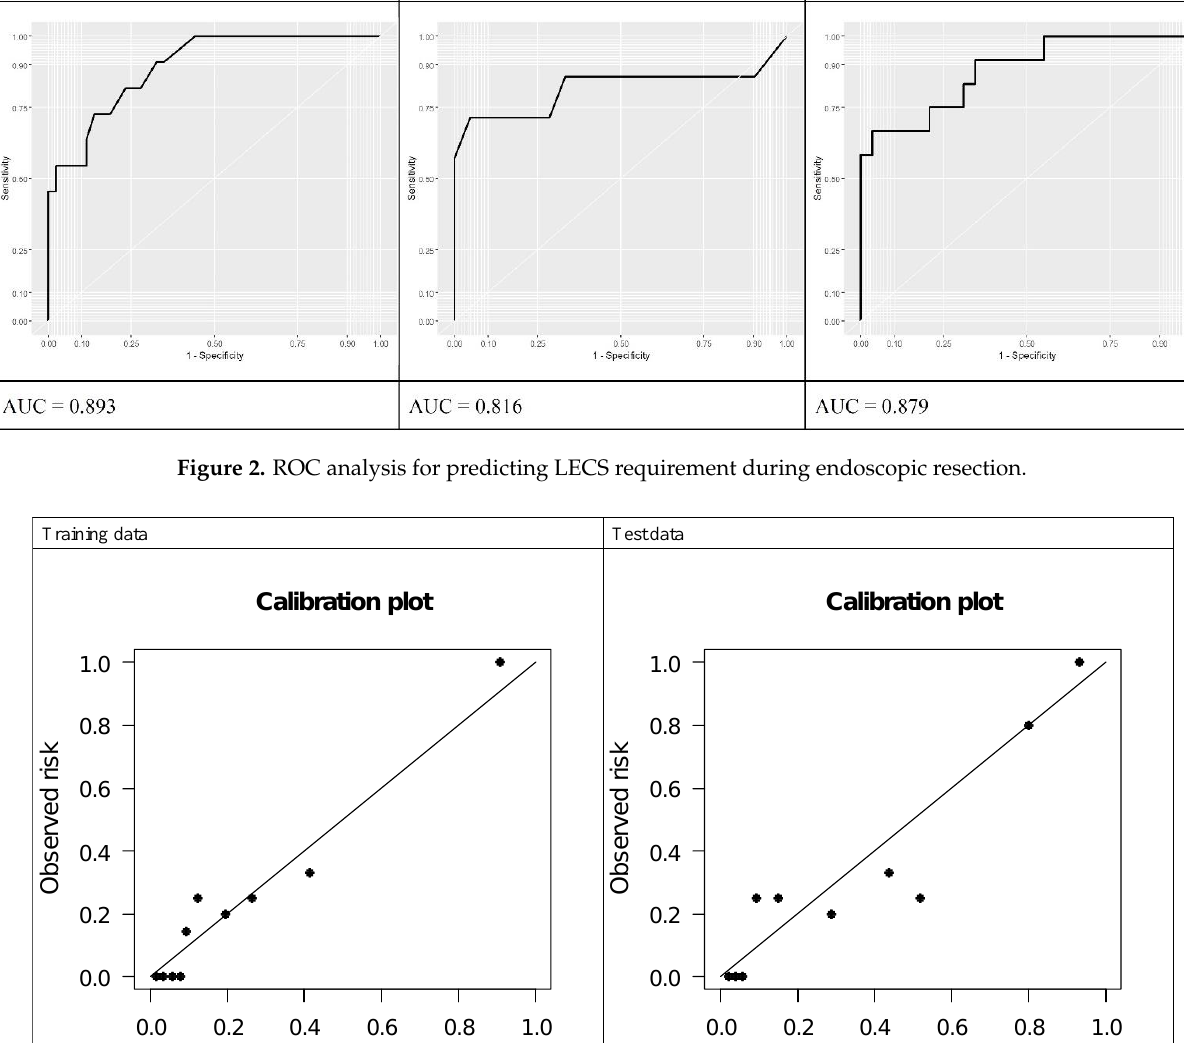
Figure 1. Nomogram of the prediction model.